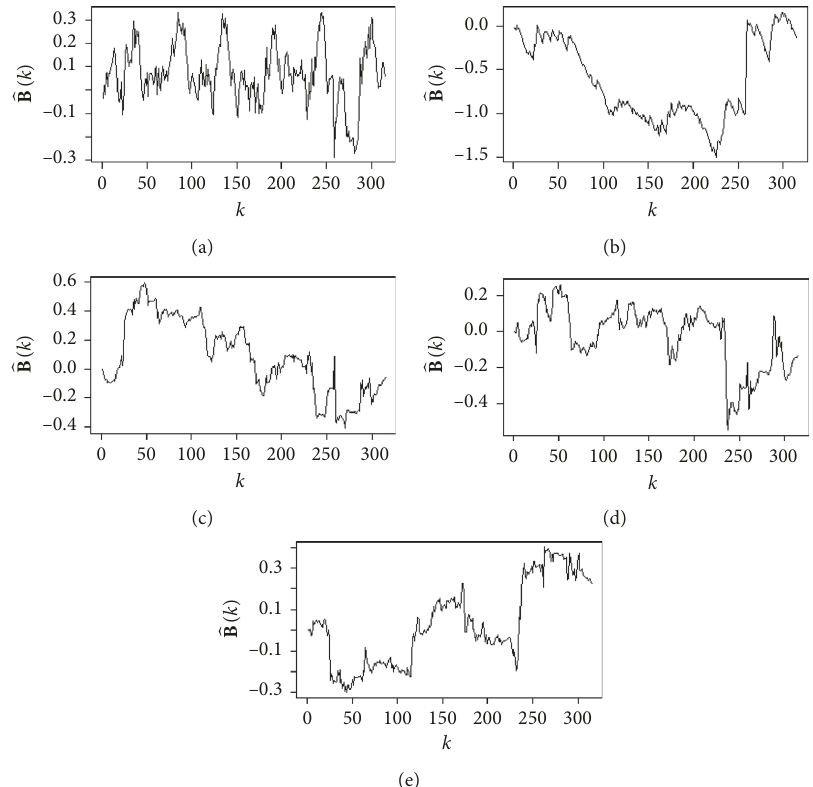
Figure 5: Values of 􏽢 B ( k ) , 0 < k ≤ n − 1, for each parameter of model given in Section 3.2.1: (a) μ . (b) σ 2 . (c) ϕ Table 3: Maximum values to test a change in parameters μ , σ 2 , ϕ To test a single change in parameters